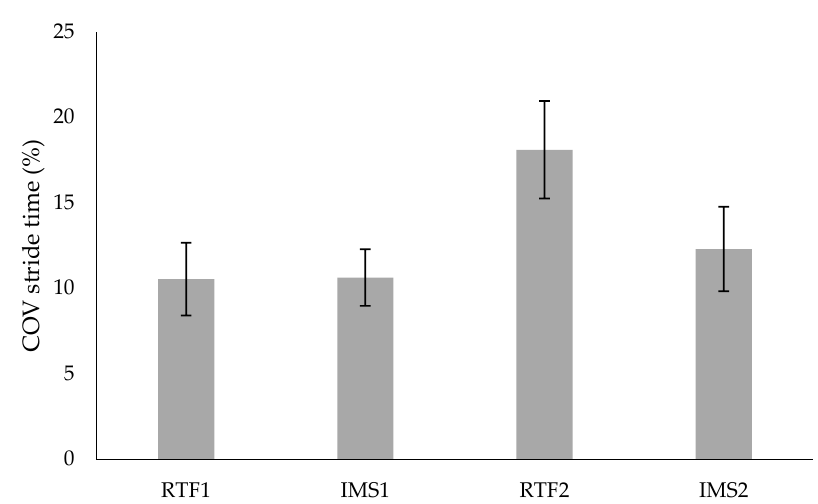
Figure 5. Coefficient of variation (COV) of stride time for SG. Values are means ± standard error.